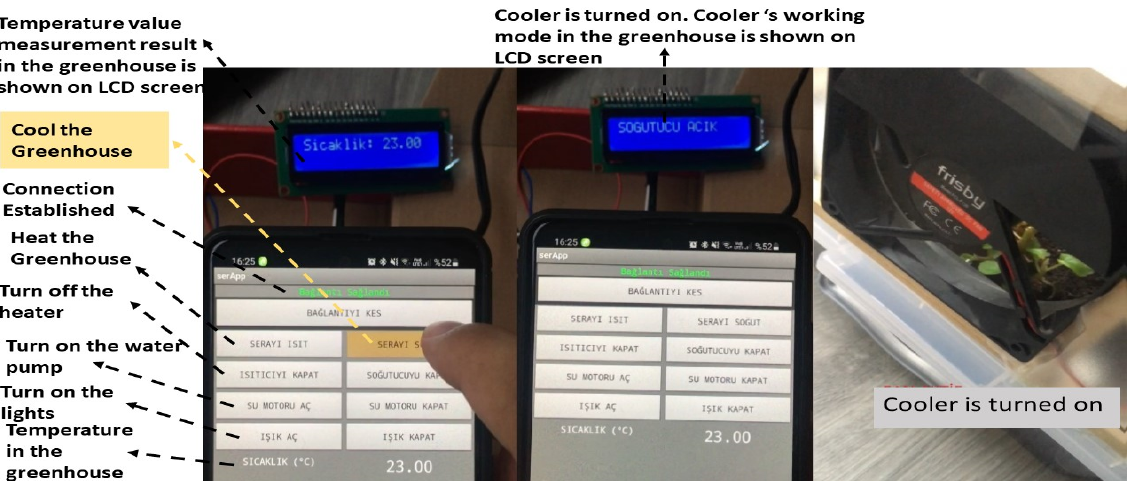
Figure 9. Operating the cooler with the app.